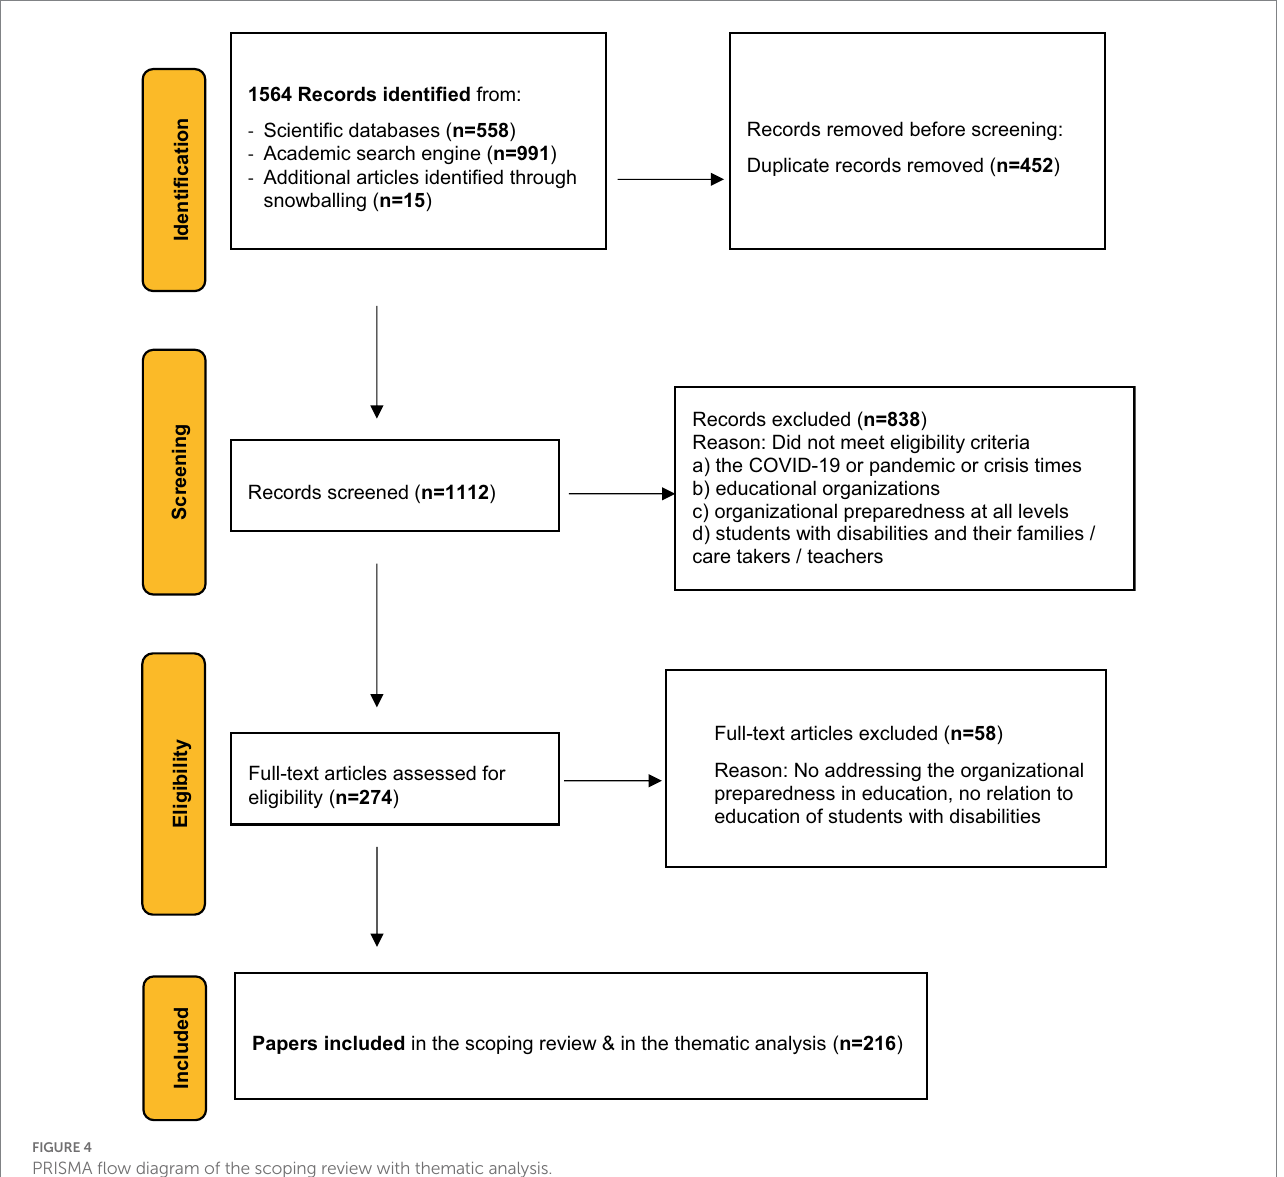
FIGURE 4 PRISMA flow diagram of the scoping review with thematic